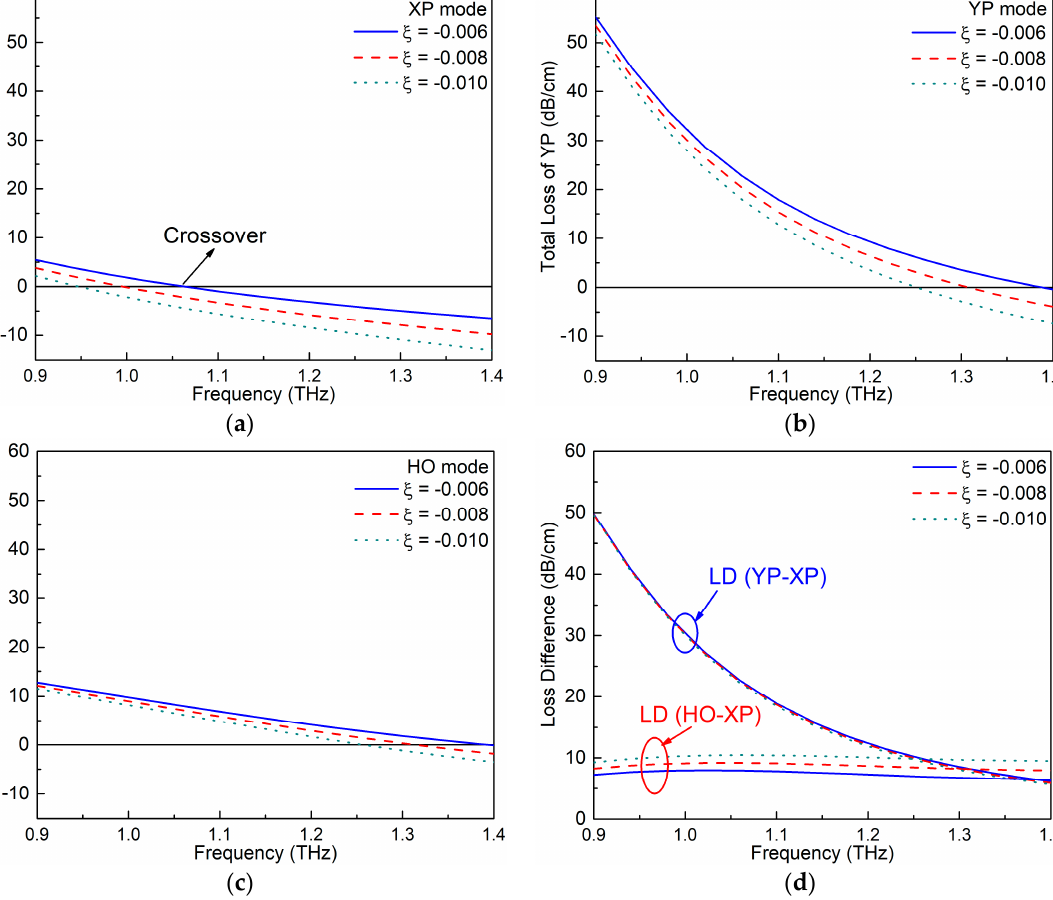
Figure 4. The TL values of the ( a ) XP, ( b ) YP, and ( c ) HO modes of the active ENZ-based PCF as functions of the frequency for different gain factors ξ . ( d ) The corresponding loss difference (LD) values between the wanted and unwanted modes. Table 1. Crossover points, interval size, SPSM bandwidth, and minimum loss difference (MLD) values for different gain factors, ξ .